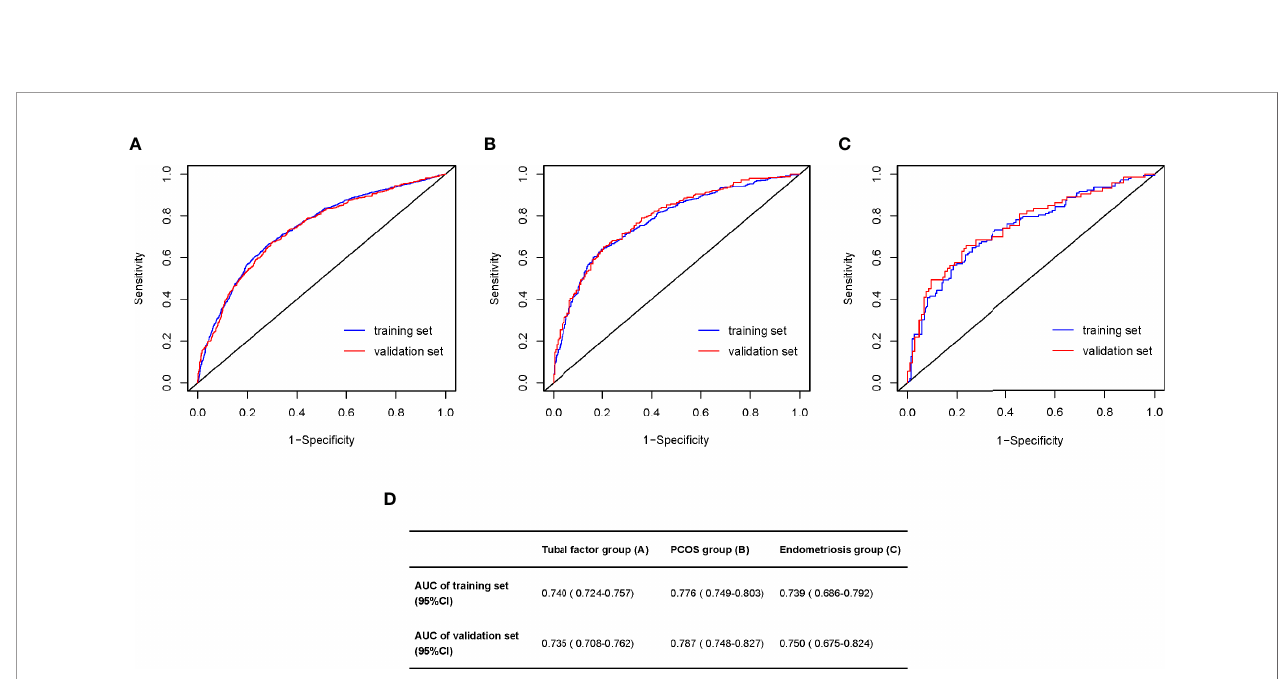
FIGURE 4 | Area under the ROC curve (AUC) for prediction the blastulation rate of infertility women with tubal factor (A) , PCOS (B) , or endometriosis (C) . (D) The table shows the value of AUC both training set and validation set in the tubal factor group (A) , PCOS group (B) , or endometriosis group (C) . ROC, receiver operator curve; PCOS, polycystic ovary